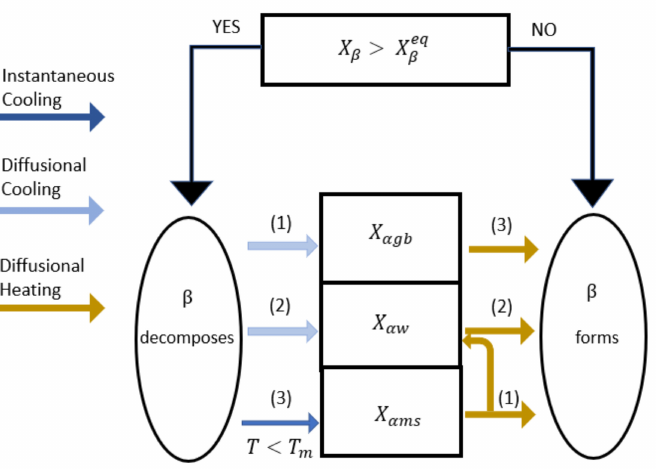
Figure 1. Solution process deployed in the semi-empirical microstructure evolution